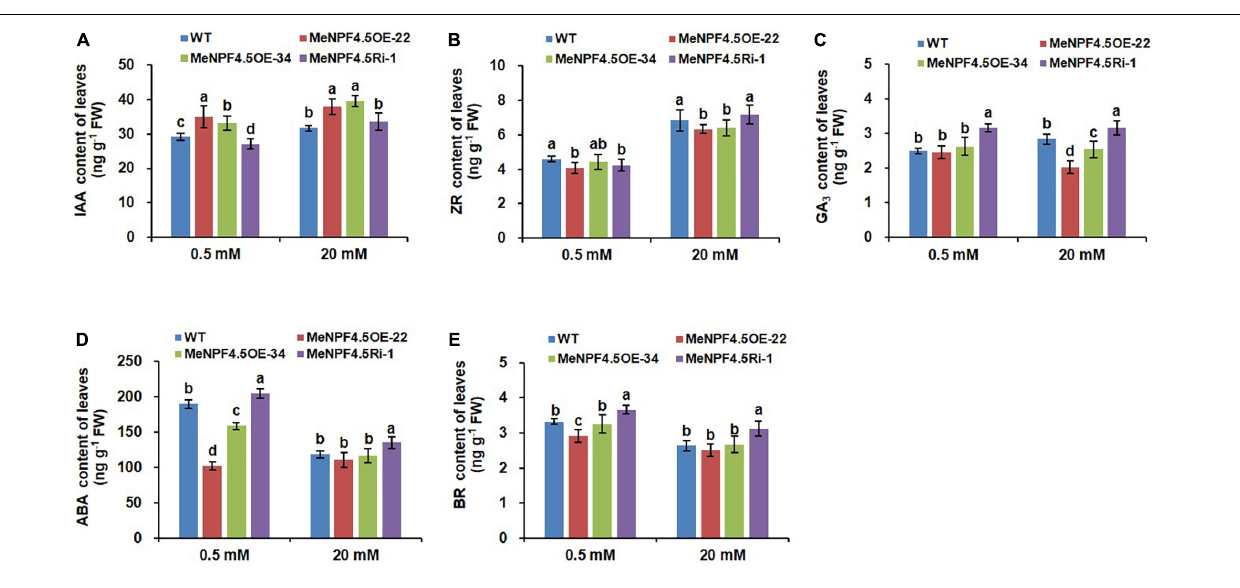
FIGURE 8 | Endogenous hormone levels in leaves of WT and MeNPF4.5 transgenic cassava plants cultivated in tissue culture for 25 days. (A–E) Contents of indoleacetic acid (IAA) (A) , zeatin-riboside (ZR) (B) , gibberellic acid (GA 3 ) (C) , abscisic acid (ABA) (D) , and brassinolide (BR) (E) . Values are the means of three biological replicates ± SE. Lowercase letters above the bars (a–d) represent significant differences between treatments as determined by Student’s t -test ( P <